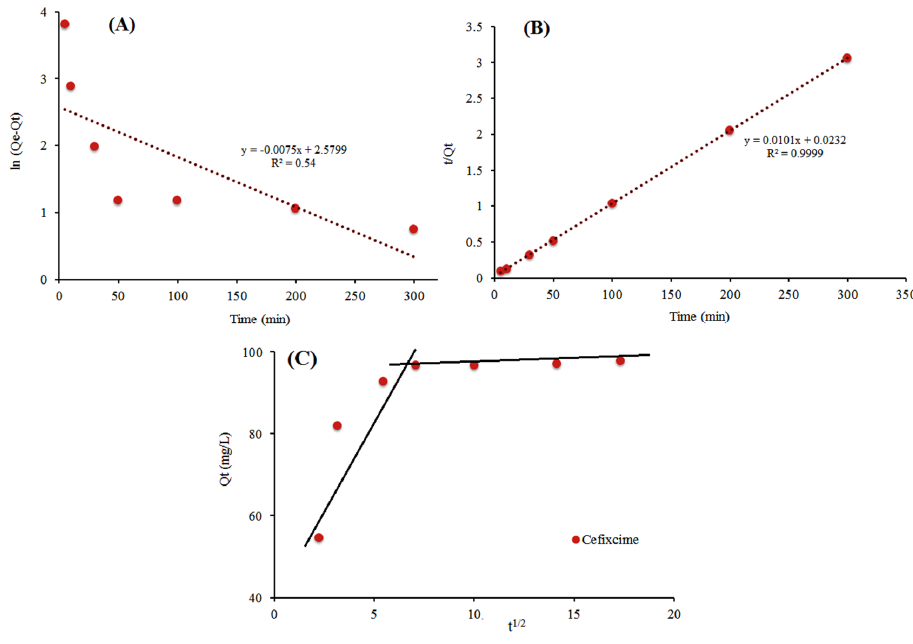
Figure 6. Adsorption kinetic models for ( A ) pseudo-first-order, ( B ) pseudo-second-order, and ( C ) intra-particle